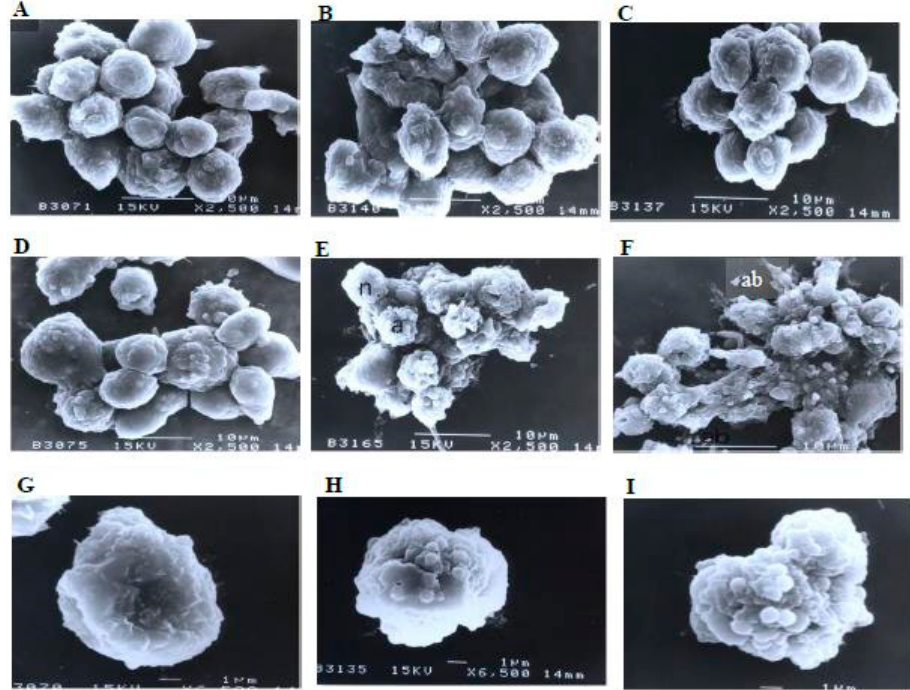
Figure 8. Scanning electron micrographs of CEM-SS cells ( A ) without (control) or treated with ( B ) 1 µ g/mL, ( C ) 3 µ g/mL, ( D ) 10 µ g/mL, or ( E , F ) 30 µ g/mL of nordamnacanthal for 24 h (2500 × magnification). ( G – I ) are close-up views of cells treated with 10 µ g/mL and 30 µ g/mL, respectively, of the